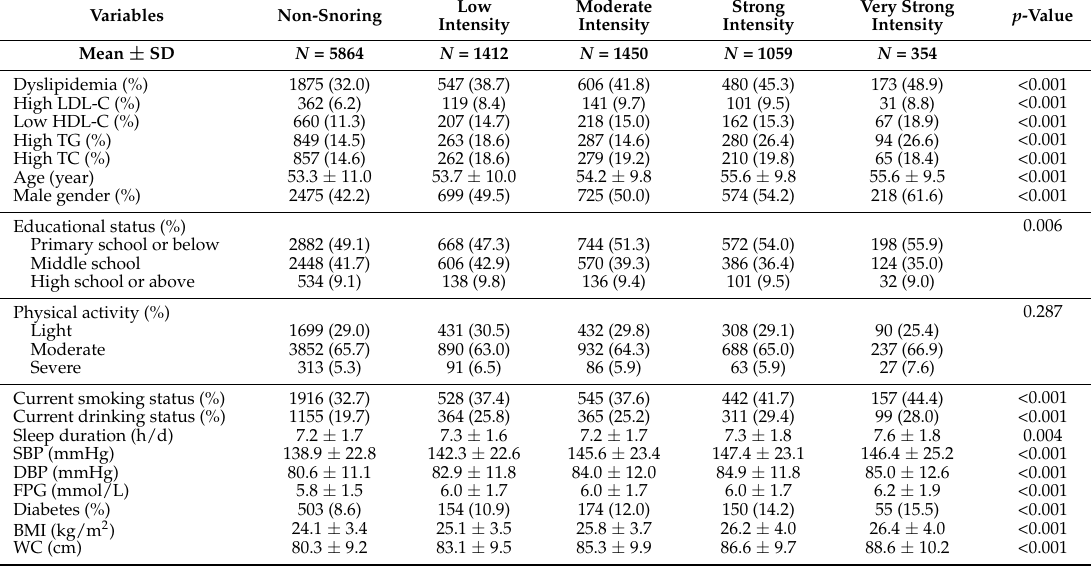
Table 1. Baseline description of participants with different self-reported snoring intensity. Variables Non-Snoring Low Intensity Moderate Intensity Strong Intensity Very Strong Intensity p